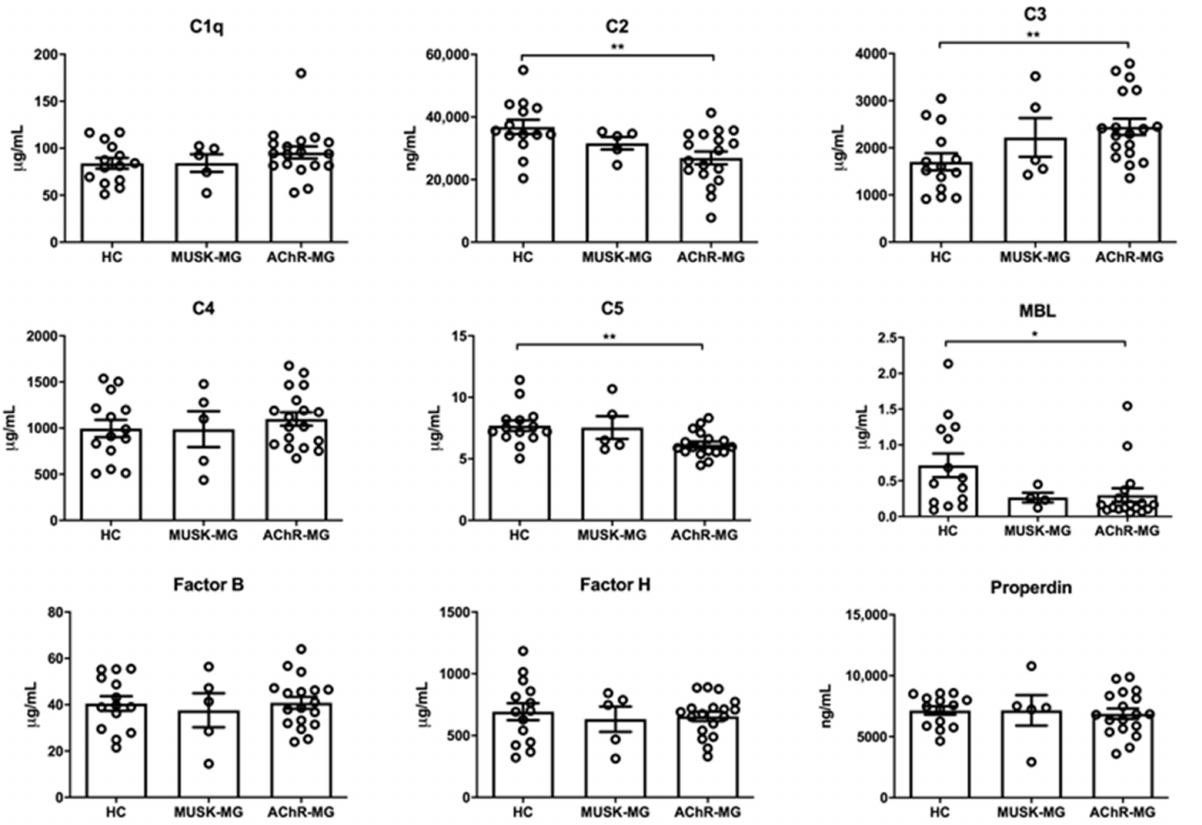
Figure 1. Quantification of complement protein components in plasma of healthy controls (HC), and MuSK-MG and AChR-MG patients. Protein concentrations of C1q, C3, C4, C5, MBL, Factor B, and Factor H were obtained by bead-based multiplex immunoassays on Luminex platform. C2 and properdin levels were estimated by a specific ELISA. For MBL data analysis, two outliers (one in the MuSK-MG and one in the AChR-MG group) were excluded based on the Grubbs’ test. No outliers were identified in the other protein datasets. A significant reduction in C2, C5 (** p < 0.01), and MBL (* p < 0.05) plasma levels was observed in AChR-MG patients compared to HC, accompanied by a significant increase in C3 (** p < 0.01). No difference in the concentration values of the remaining complement components was found among AChR-MG and MuSK-MG patients, and HC ( p > 0.05). Data in the graphs correspond to mean concentration values ± standard error of the mean (SEM) obtained in each sample group. Mann–Whitney test, * p < 0.05; ** p <